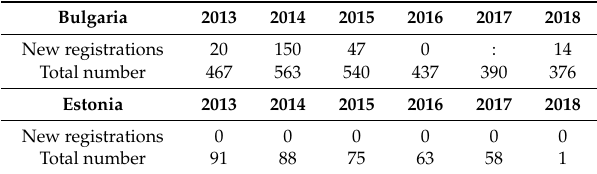
Table 1. The comparison of data on new registrations and numbers of electric buses on the example of Bulgaria and Estonia [Source: https: // www.eea.europa.eu / data-and-maps / indicators / proportion-of- vehicle-fleet-meeting-4 /